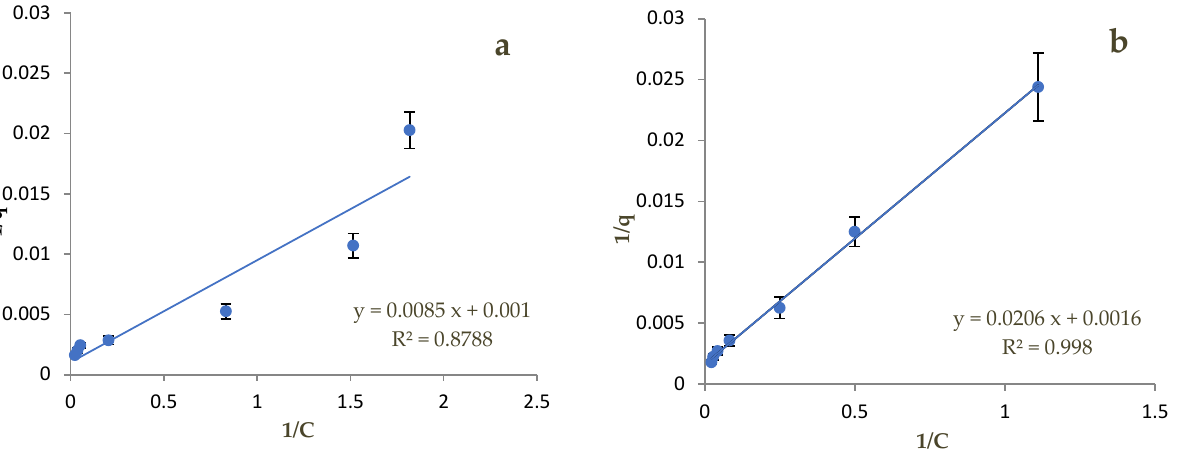
Figure 6. The Langmuir isotherm adsorption of Pb in the presence of Zn in the alkaline soil sample ( a ) and in the acidic soil samples ( b ).